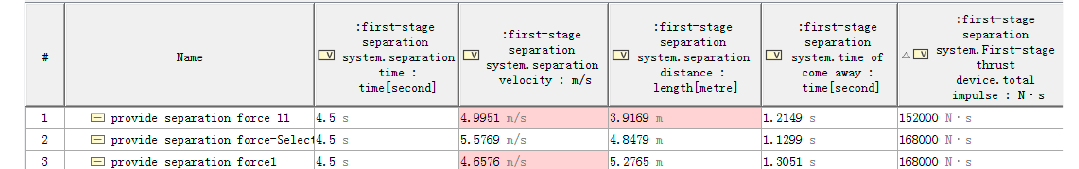
Figure 12. Requirement change impact analysis process.